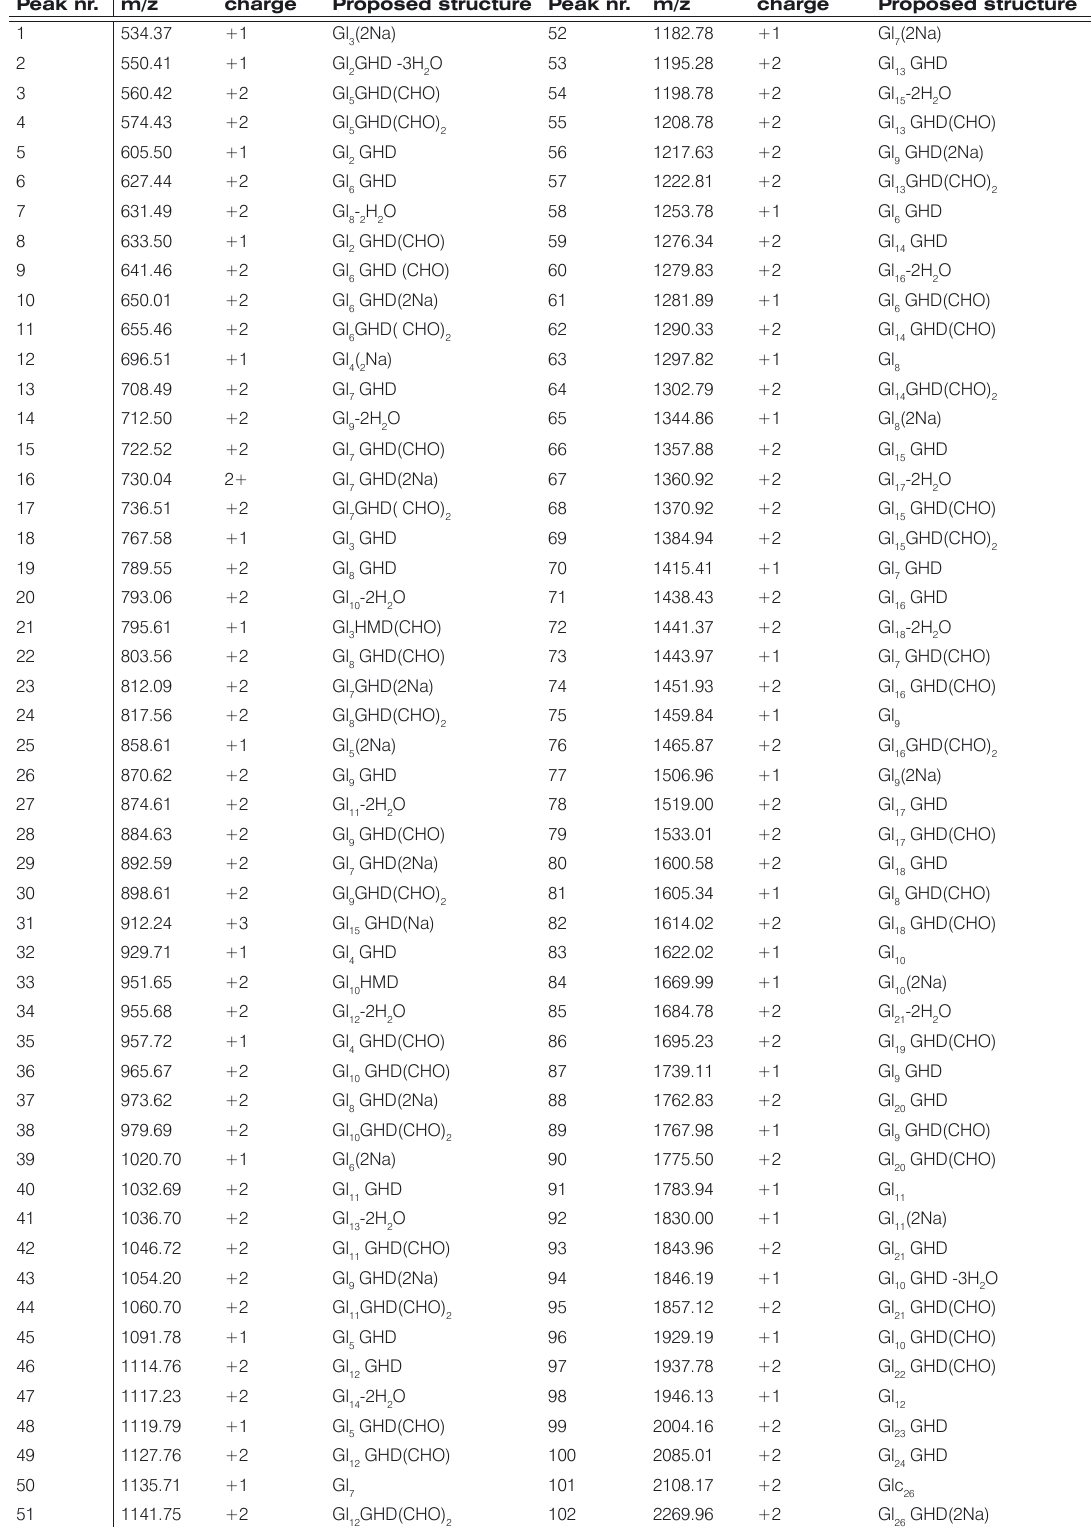
Table 1. Assignment of the major pseudomolecular ions detected in HMD-modified maltodextrin sample Peak nr.